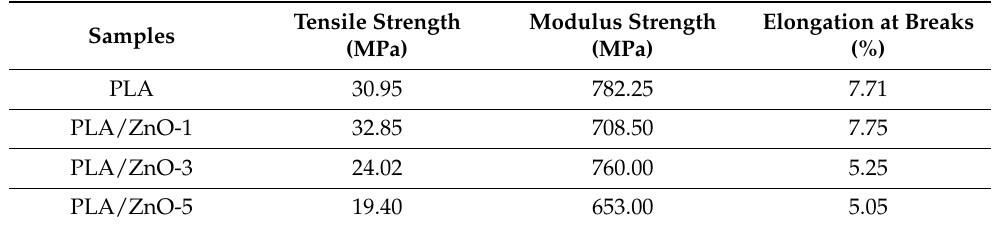
Figure 5. Optical images of ASTM D638-14 type IV tensile test specimens of ( a ) neat PLA, ( b ) PLA/ZnO-1, ( c ) PLA/ZnO-3, and ( d ) PLA/ZnO-5, respectively. Table 2. Mechanical properties of 3D printing filaments from neat PLA and PLA composited with ZnO nanoflowers at varying